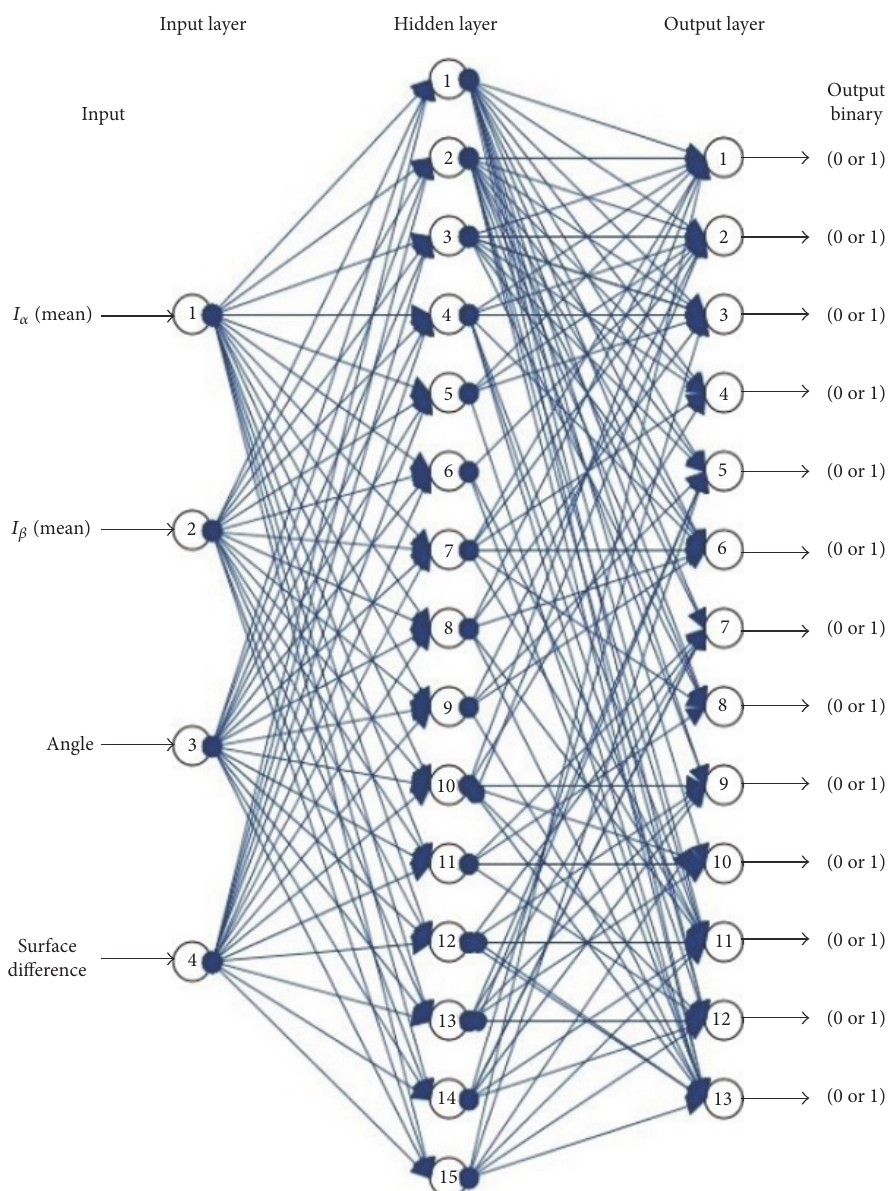
Figure 5: Basic architecture of artificial neural